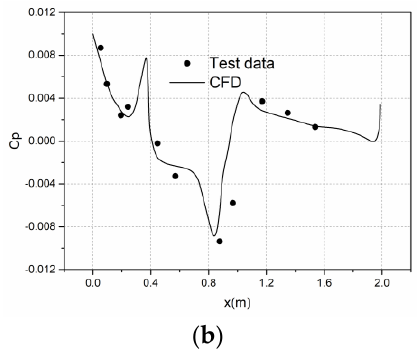
Figure 12. Pressure coefficient distribution in the center line of the top fuselage. ( a ) μ = 0.151. ( b ) μ = 0.231.